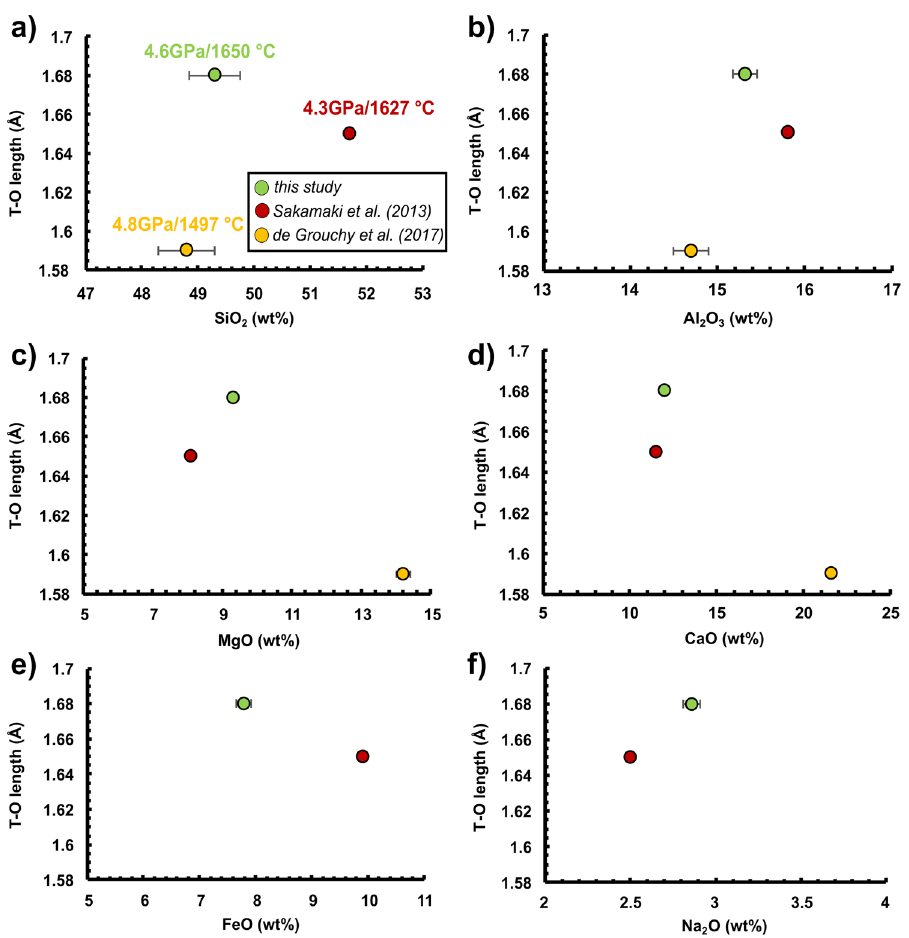
Symbols are as in Fig.